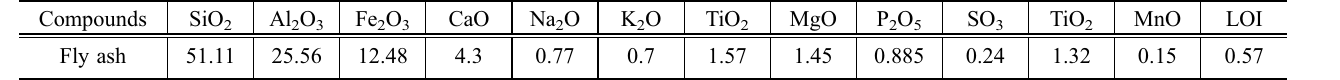
Table 1 Chemical composition of fly ash